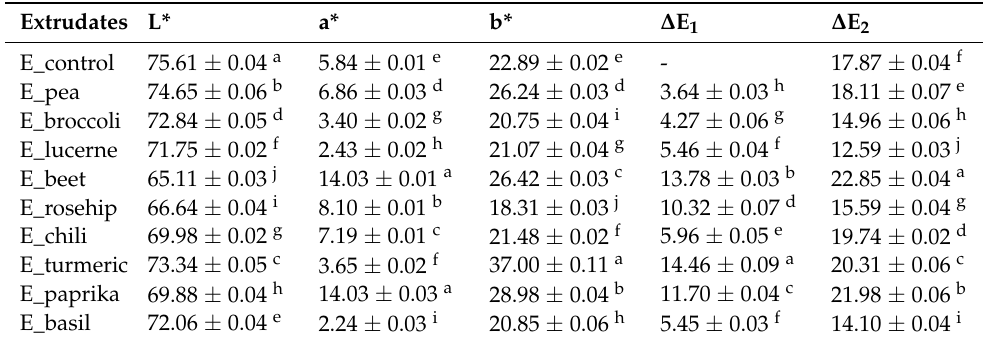
Table 3. Color coordinates (L*, a*, and b*) of the extrudates and total color